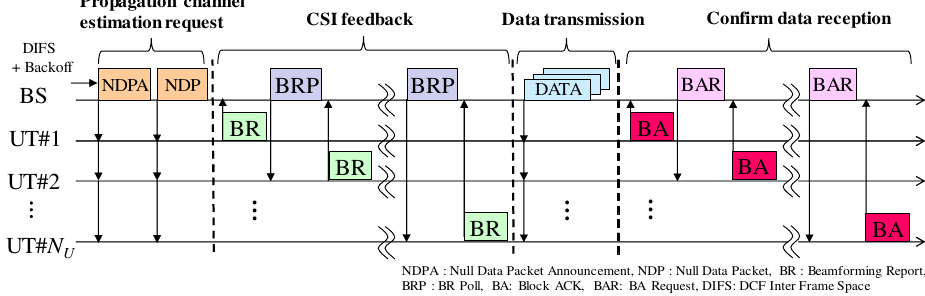
Figure 6. Downlink multi-user (MU)-MIMO procedure under IEEE802.11ac.